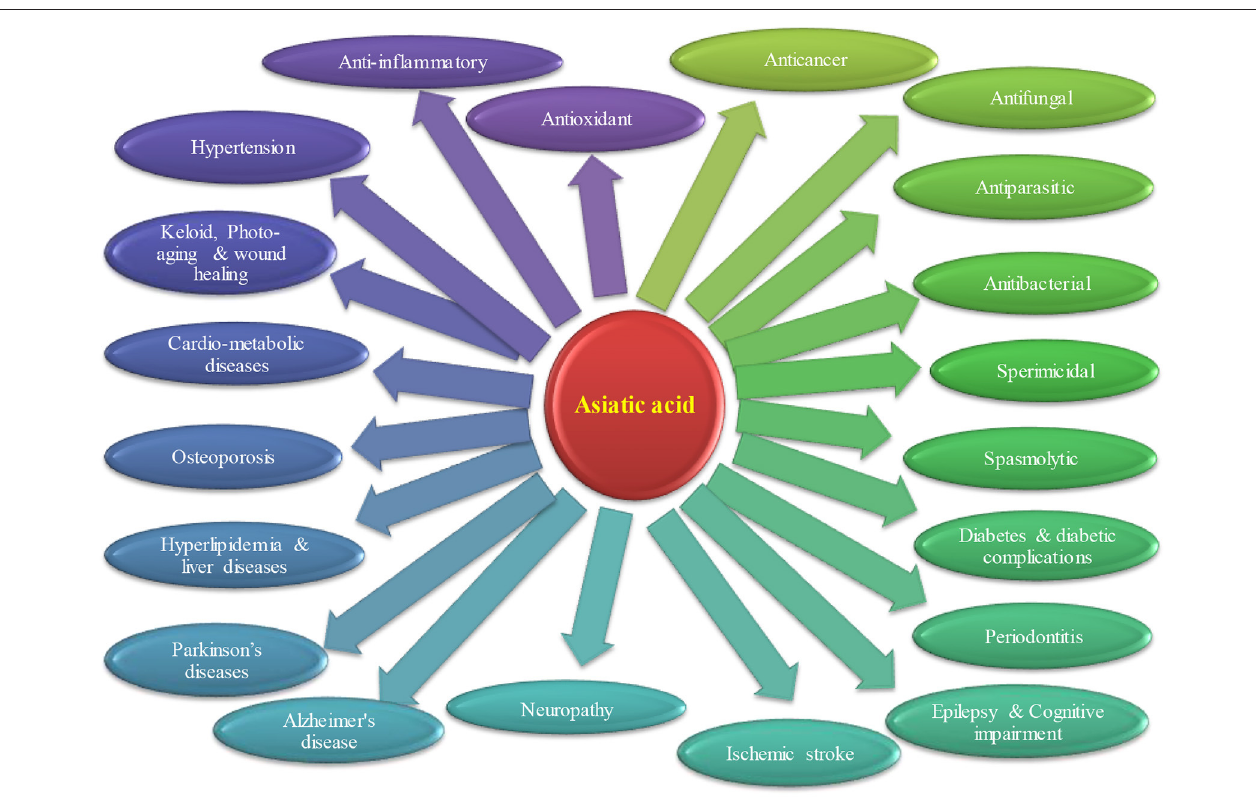
FIGURE 2 | Therapeutic potential of asiatic acid in different